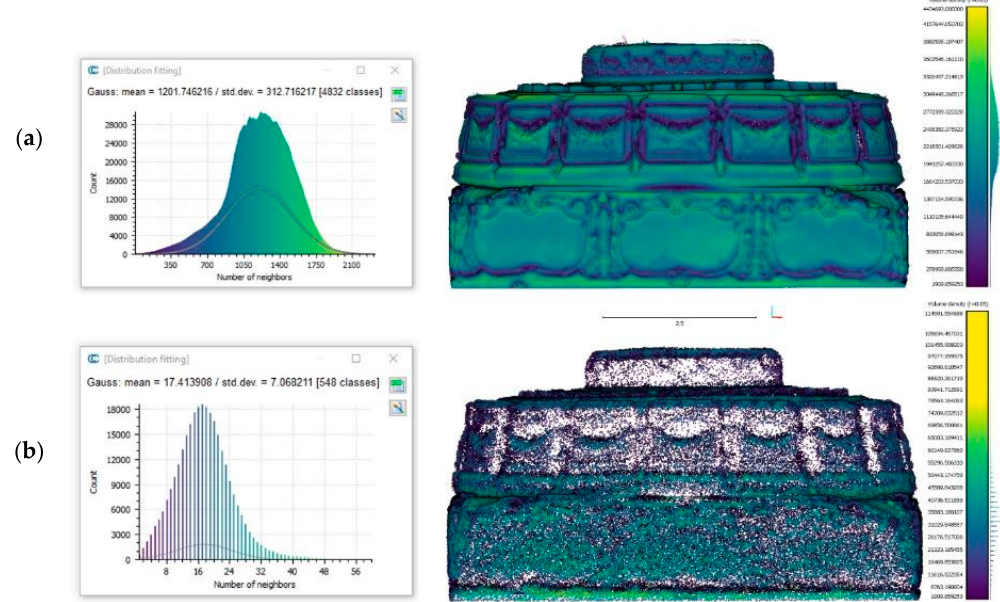
Figure 16. The two density analysis maps on the Roses Chamber in ( a ) LiDAR and ( b ) ZEB models.